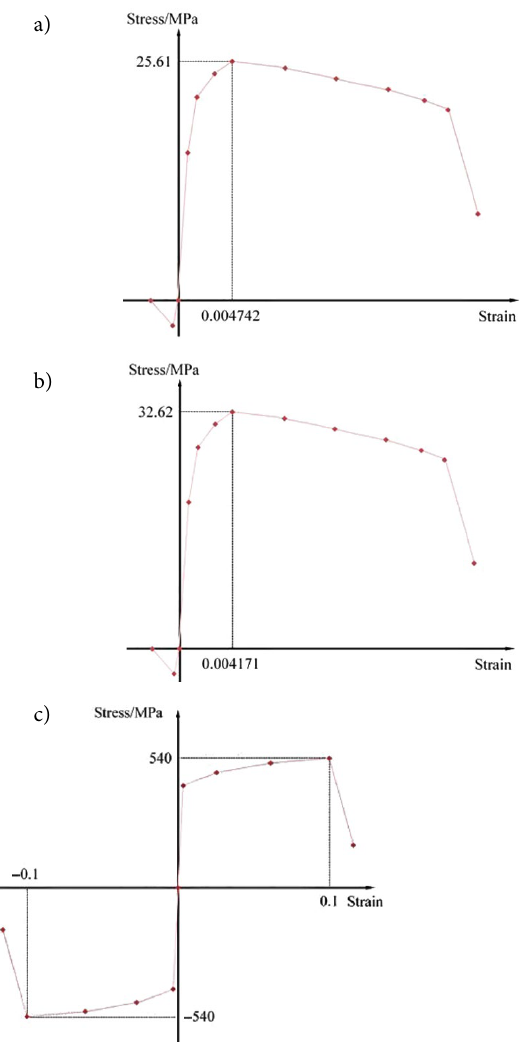
Figure 6. Frame columns are adopted with PMM plastic hinges, frame beams and connecting beams are adopted with M3 plastic hinges, their M-Teta curves are shown in Figure 7. The two floors at the bottom of the core tube are